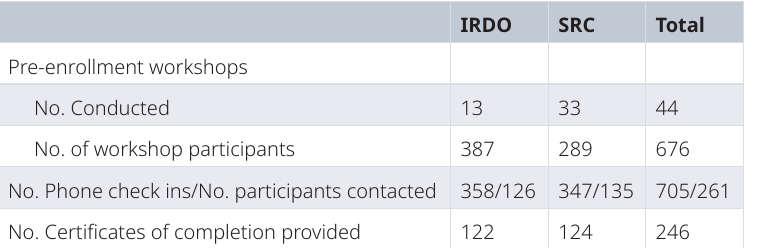
Table 1. Engagement activities by site and overall for